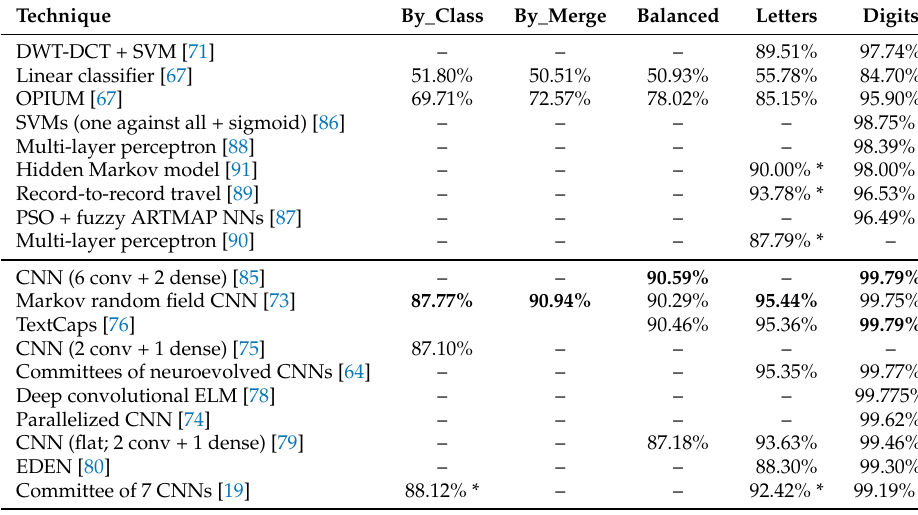
Table 3. Side-by-side comparison of the results for the EMNIST dataset, including works using similar datasets from NIST Special Database 19. Best results are boldfaced. Results marked with a star (*) indicate that they refer to works using samples from NIST SD 19 which are similar but not equivalent to EMNIST (samples are the same, but they are not submitted to the preprocessing stage used in EMNIST, described in the